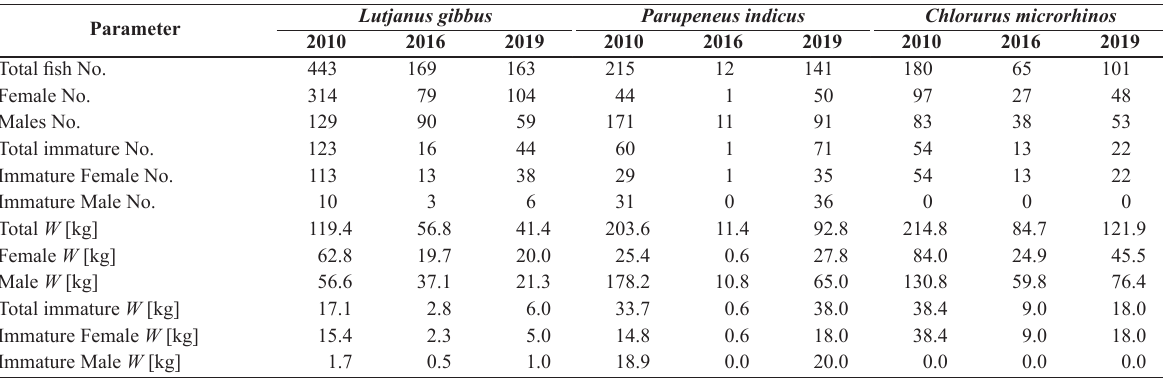
Table 2. The number and estimated weights of immature and mature fishes for three reef fish species from Fijian fish market surveys (years 2010–2013 and 2016–2018). The fish number and weights of the reproductive samples (year 2019) were